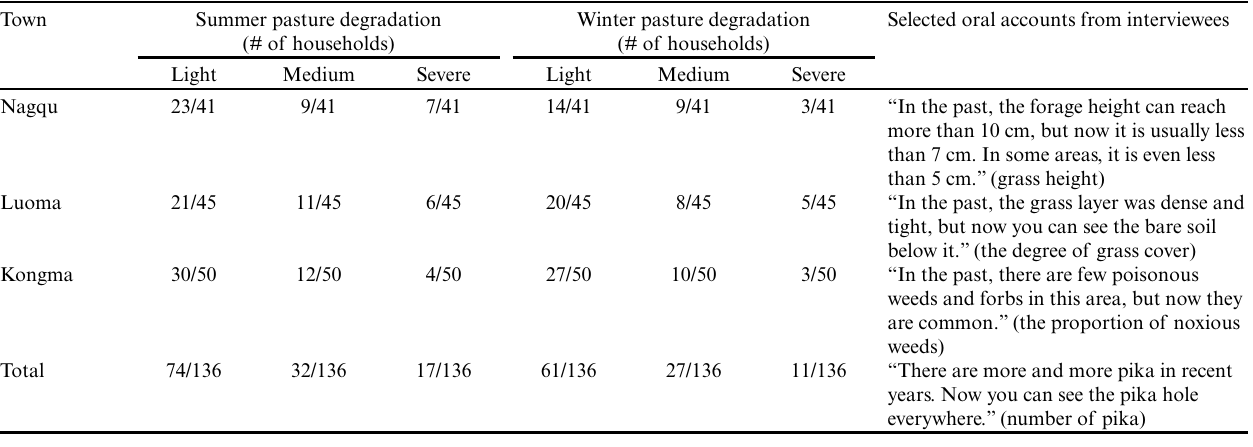
Table 1 . Number of surveyed households whose pastures have degraded.